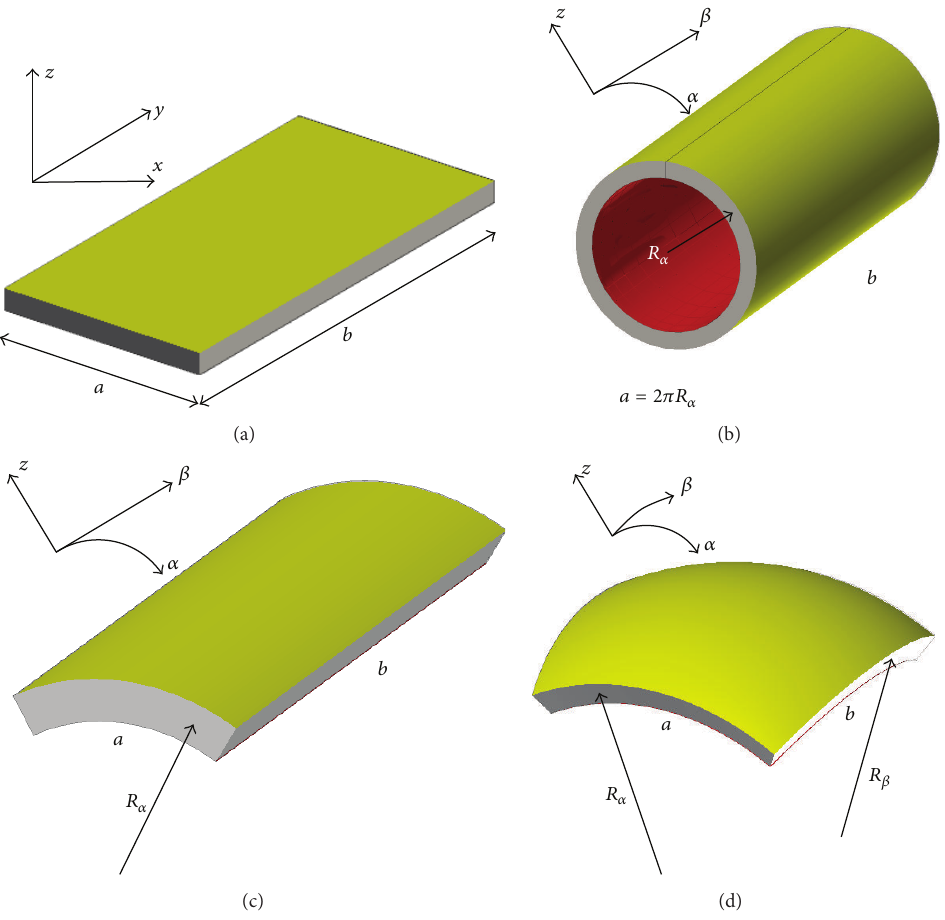
Figure 1: Geometries of plates and shells with constant radii of curvature and their local reference